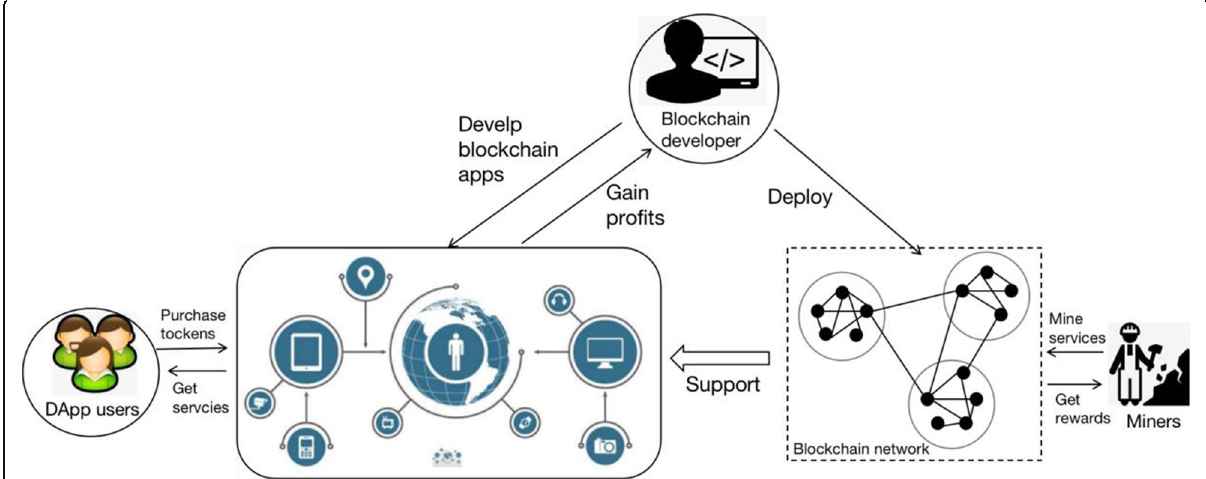
Fig. 11 Blockchain-based cloud-edge business ecosystem